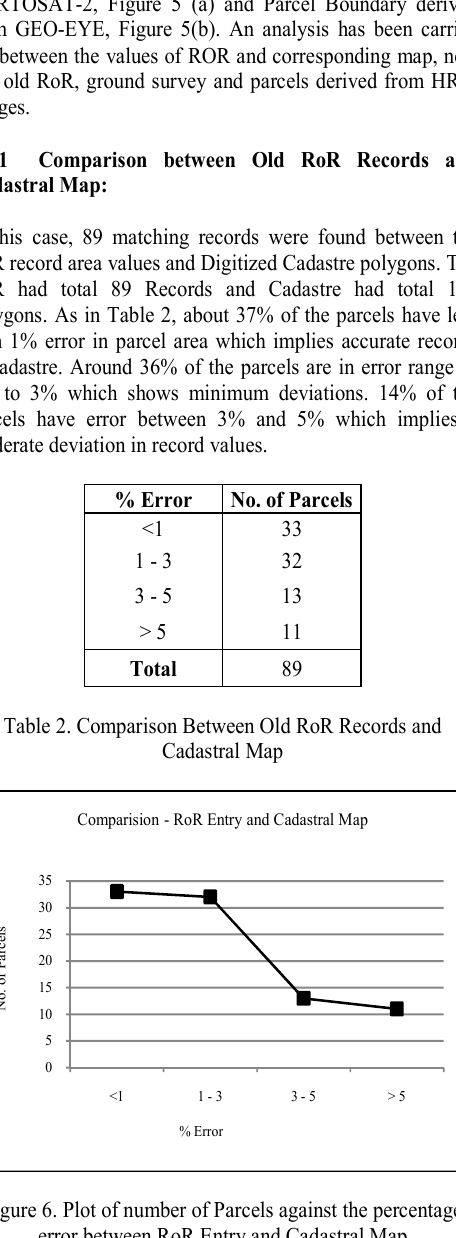
Figure 6. Plot of number of Parcels against the percentage error between RoR Entry and Cadastral Map However, 12% parcels have area error more than 5% which indicates deviation over the threshold. This difference have occurred due to representation of surface/actual measured area on the ground in RoR details and planimetric area derived from cadastral map compiled with the adjustment of individual parcels in the map. This problem can be overcome by using the ortho image of aerial as well as satellite data.